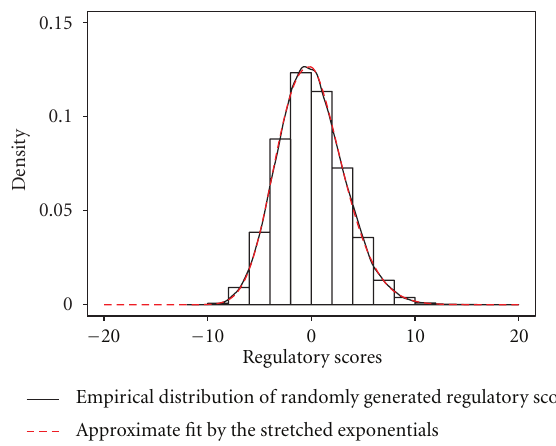
Figure 2: Probability density function of randomly generated regu- latory scores and the approximated fit by the stretched exponentials. The solid line denotes the empirical probability density function of regulatory scores obtained by the LIMMA-based method based on randomly generated condition clusterings, while the dotted line denotes the stretched exponentials (7) with h max = 0 . 127, b r = 0 . 024, b l = 0 . 083, c r = 2 . 45, c l = 1 . 70, and x max = − 0 . 050.